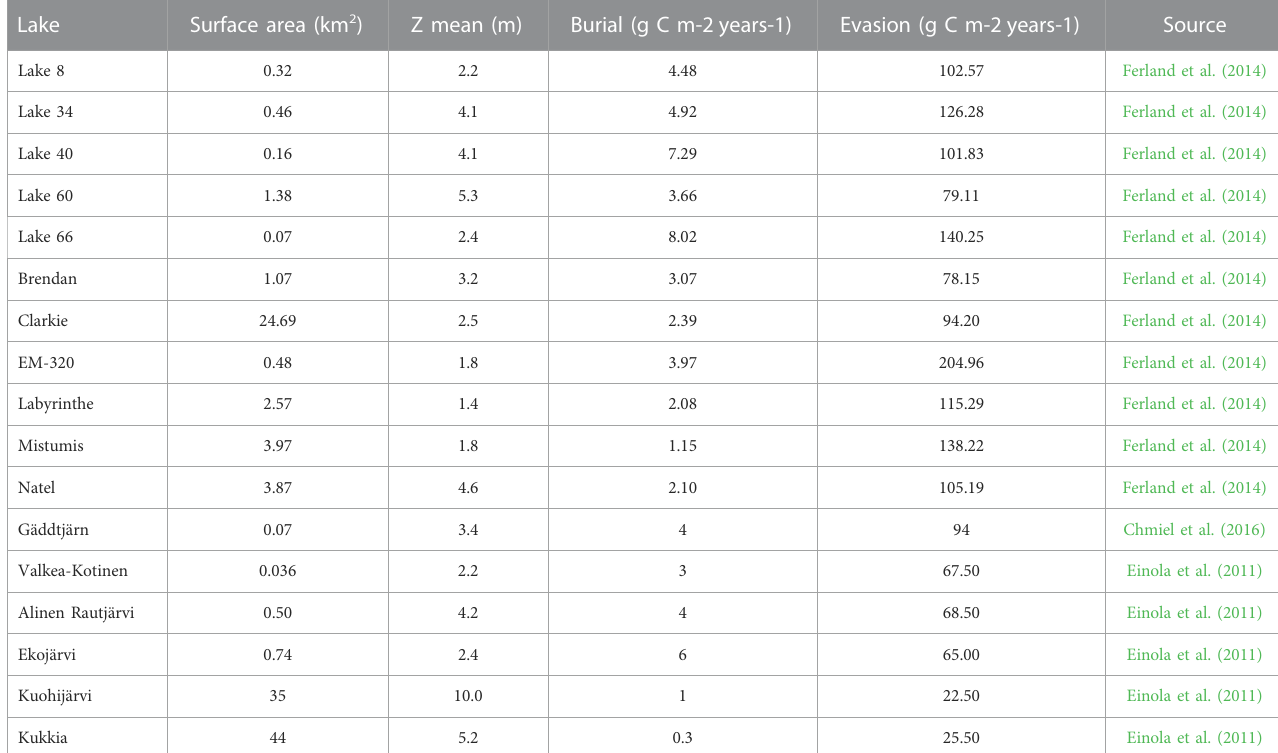
TABLE 1 Data used to calibrate the burial